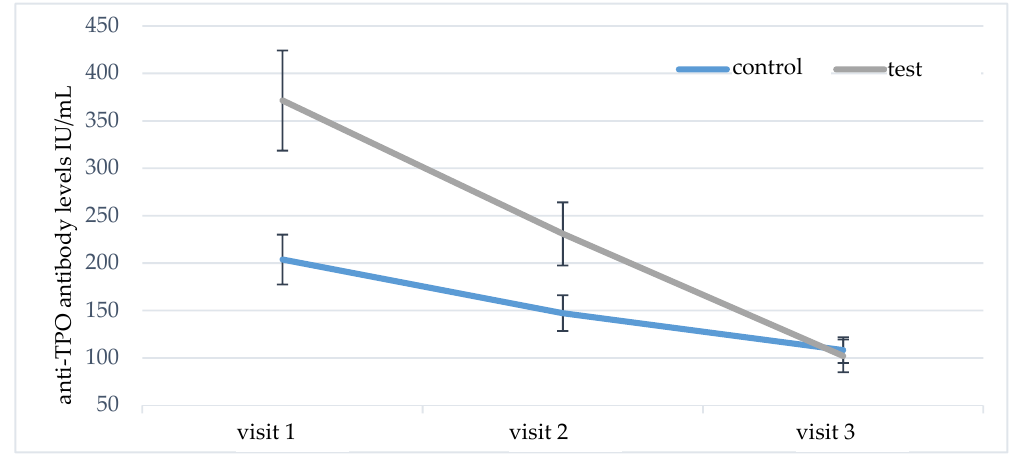
Figure 3. Comparison of test group A and control group B in terms of anti-TPO antibody levels during the six-month nutritional intervention.